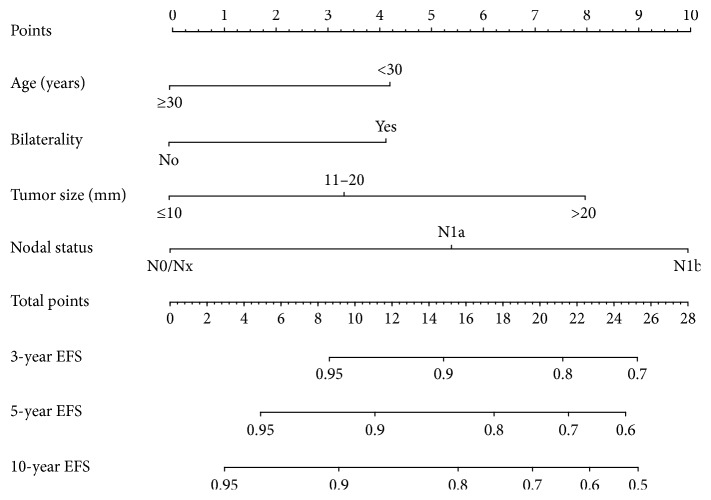
The nomogram for predicting event-free survival (EFS) of papillary thyroid cancer (the nomogram was used as follows: possible values of each variable from an individual patient are located on each variable axis, and a line is drawn upward to determine the points got for each variable on the point axis. The sum of these points is located on the total point axis. Then, a line is drawn downward to the survival axes to determine the likelihood of 3-, 5-, or 10-year EFS. A specific example is shown in Supplementary ).